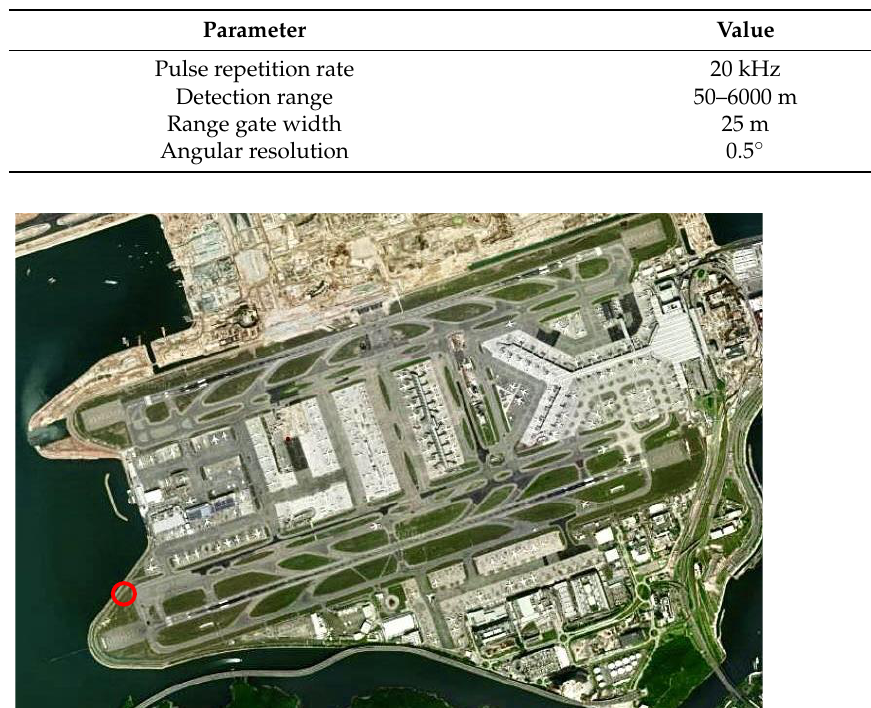
Figure 1. Lidar (red circle) at the Hong Kong International Airport.